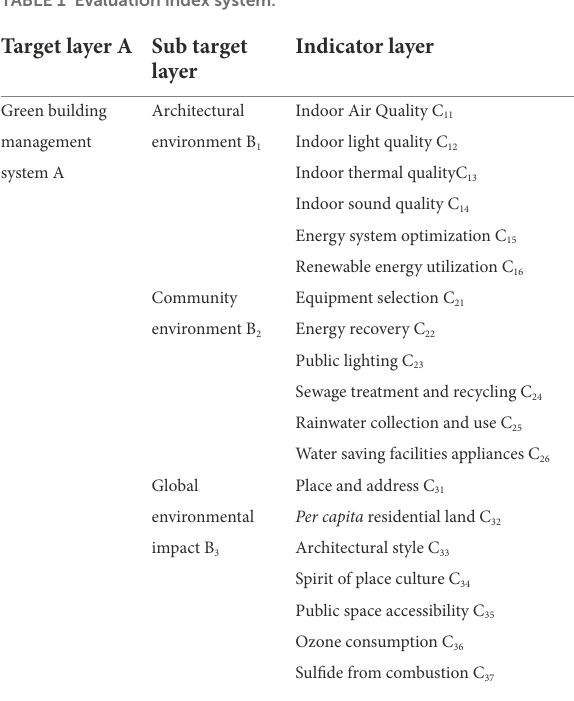
TABLE 1 Evaluation index